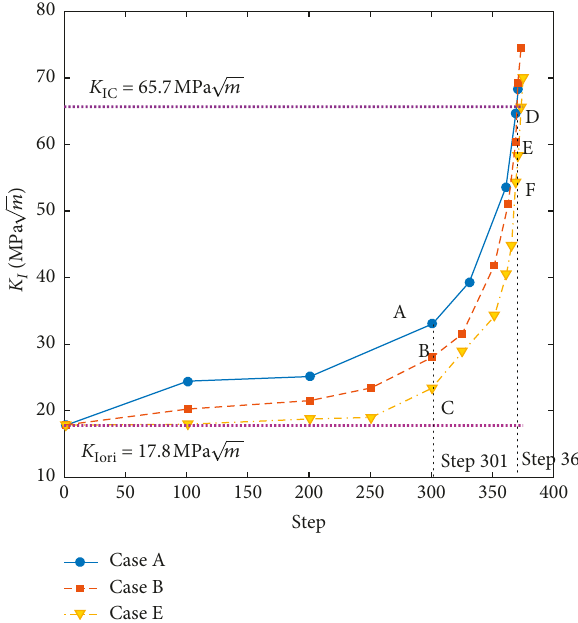
Figure 20: Time-varying curves of the stress intensity factor K steel wires corresponding to the cases in Figure 19. The original data of the table and figures in this section are provided in S2 File of the section “Supplementary